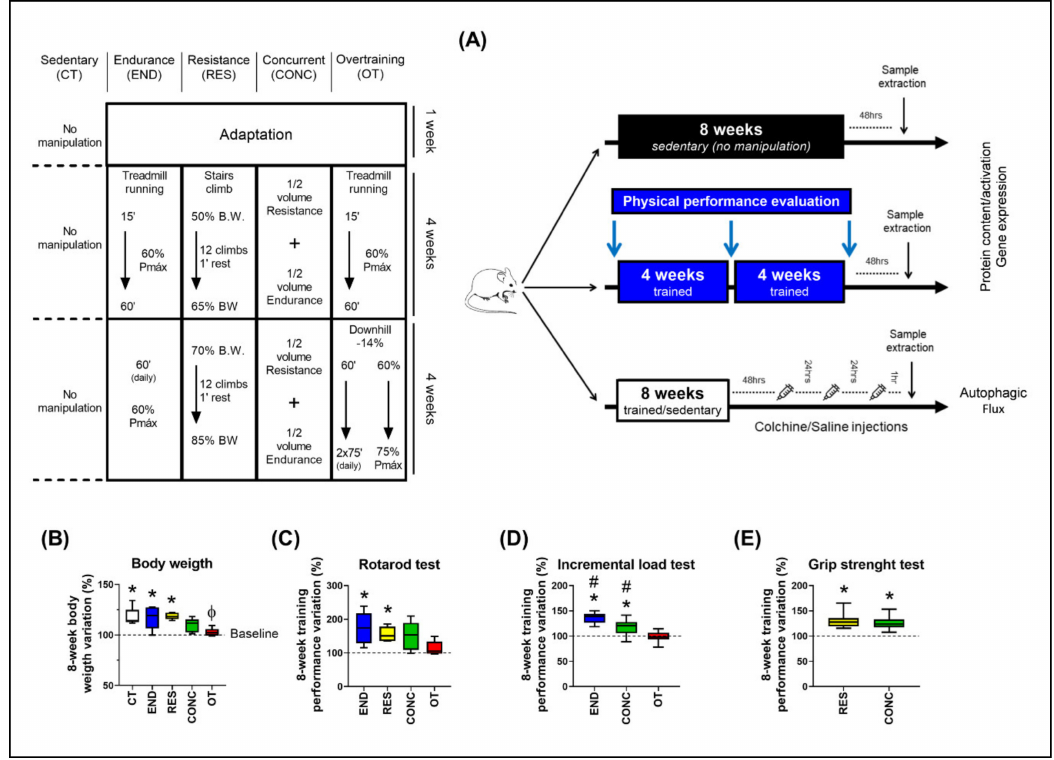
Figure 1. Schematic illustration of the experimental procedures ( A ). Body weight variation between week 8 and 0 ( B ). Performance variation (%) between weeks 8 and 0 for the incremental load test ( C ), rotarod test ( D ), and grip strength test ( E ). Data correspond to the mean ± SEM of 7–10 mice / group. * p ≤ 0.05 vs. baseline; Φ p ≤ 0.05 vs. CT and RES; # p ≤ 0.05 vs. other experimental groups. END (Endurance; submitted to the chronic endurance exercise protocol); RES (Resistance; submitted to the chronic resistance exercise protocol); CONC (Concurrent; submitted to the chronic concurrent exercise protocol); OT (Overtraining; submitted to the chronic exhaustive exercise